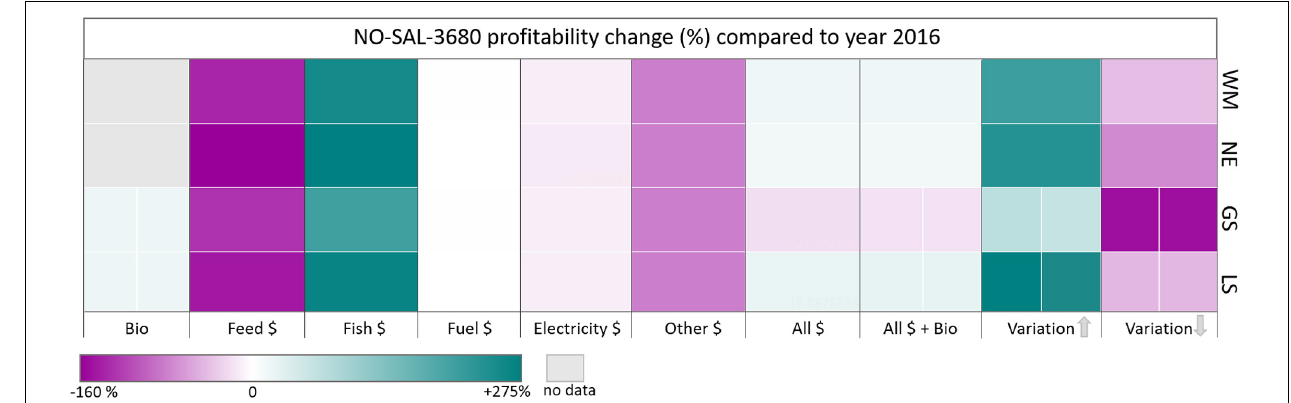
FIGURE 8 | Separate effects of different factors on profitability (market returns against cash costs without interests) of a typical Norwegian salmon farm under the four scenarios World Markets (WM), National Enterprise (NE), Global Sustainability (GS) and Local Stewardship (LS). Bio = harvest and feed conversion ratio changes, for an extreme cold (left column) and warm year (right column), $ = price. Upper and lower variation refers to 95% upper and lower probability ranges from Monte Carlo simulation of future price